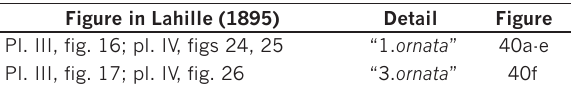
Table 15. Specimens of Voluta fusiformis ornata figured by La - hille (1895) with the detail of the inscriptions on their shells and figures here.